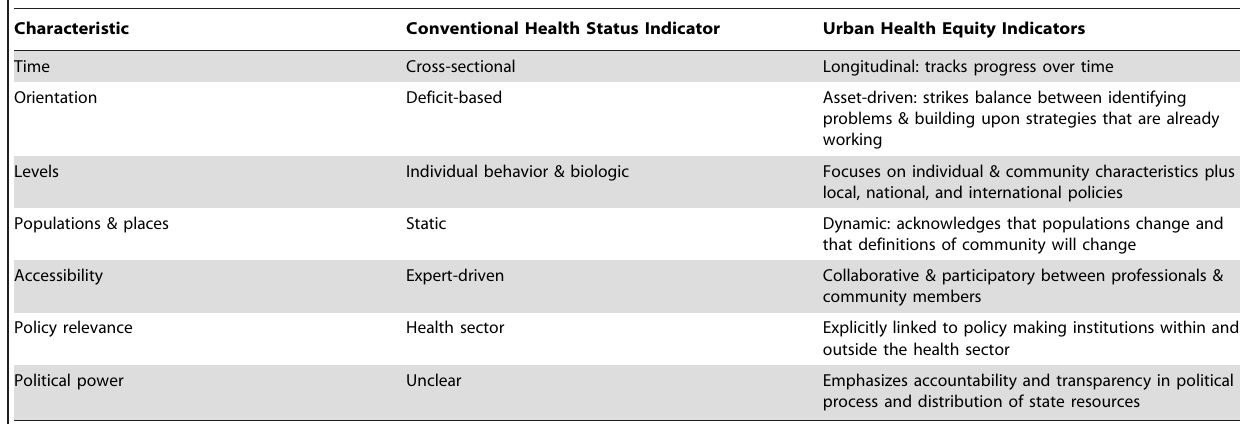
Table 1. Comparison of conventional and our approach to urban health equity